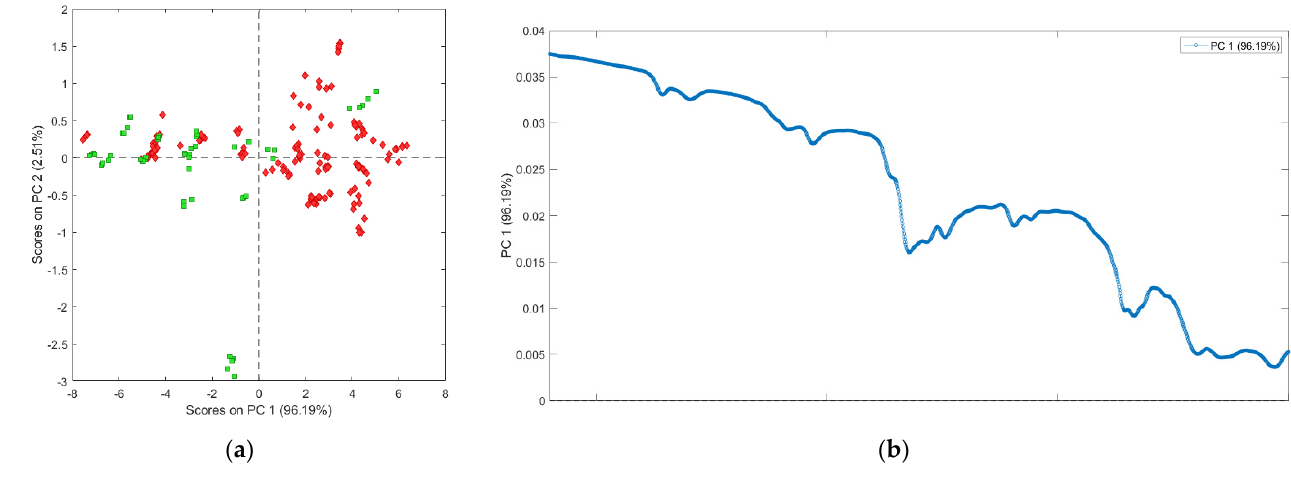
Figure 4. PCA score plot of the first two principal components ( a ), according to bromine content and loadings plot of the first principal component ( b ).